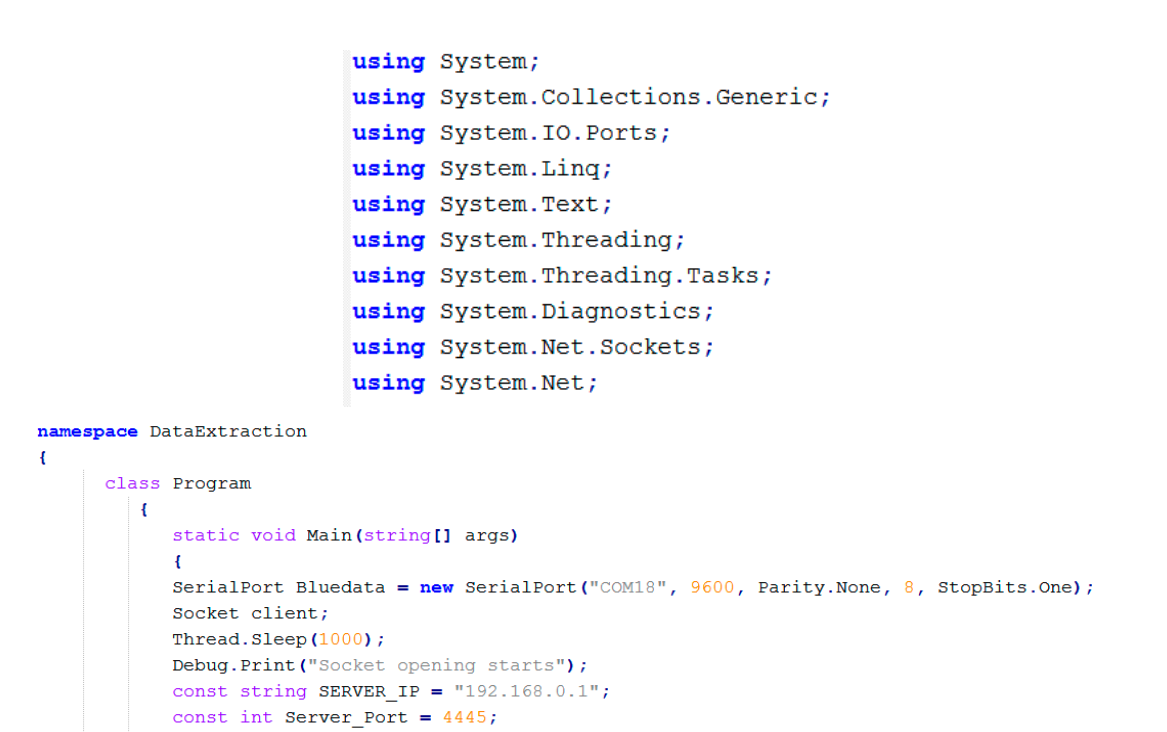
Figure A1. Meta-program fragments in PHP, using HTML for representation of parameters and their values.